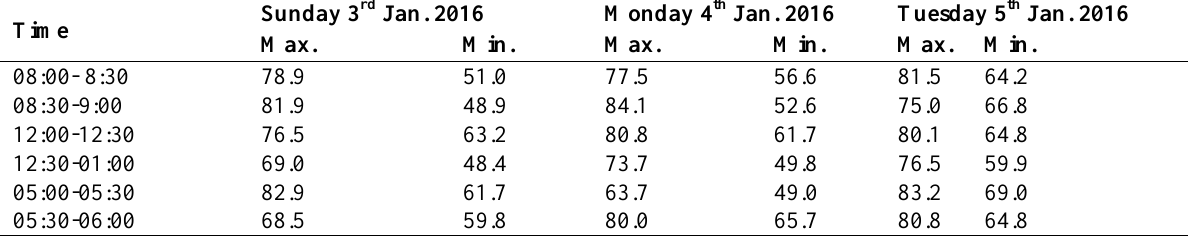
Noise levels of Al Askary region listed in table prescribed limits in table 2 which is 55 dB and Table 8, Noise pollution levels at Al Askary region.